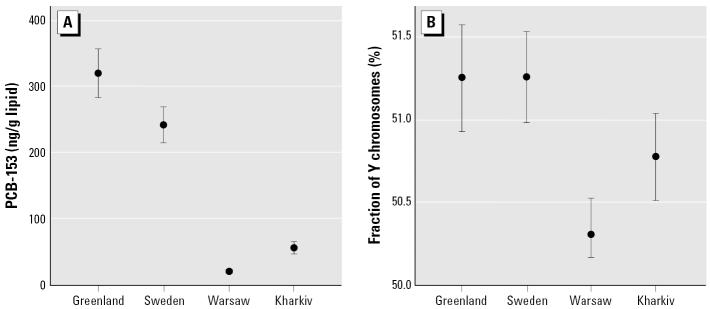
Distribution of PCB-153 (ng/g lipid) serum levels (A) and fraction of Y-bearing sperm in ejaculates (B) among men from different countries studied. Values shown are means and 95% CIs.